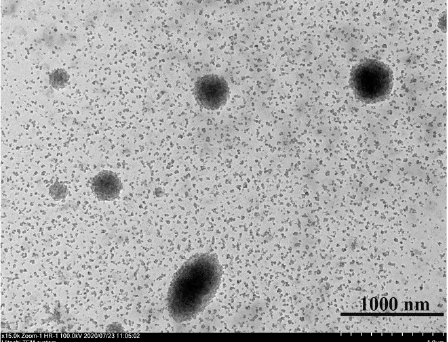
Figure 7. TEM image of aggregates formed by macrocycle 13 and G2 at 1:1 ratio (DMSO, 1 × 10 − 4 M).